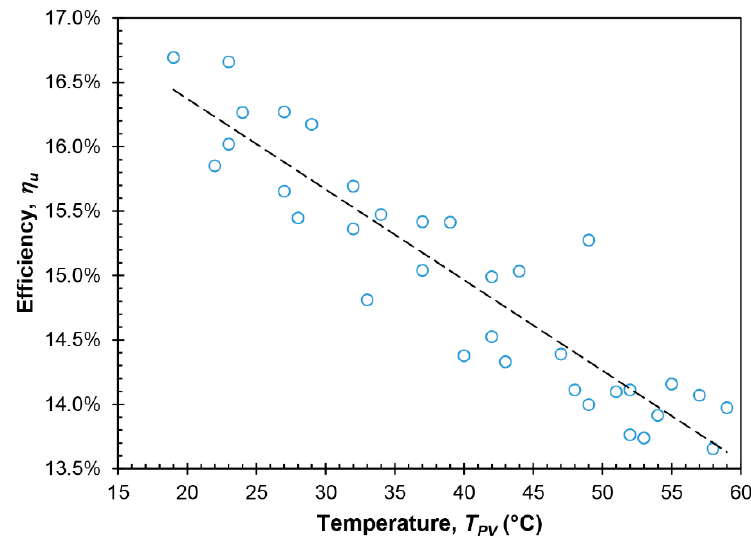
Figure 10. Effect of temperature on efficiency for the PV module.